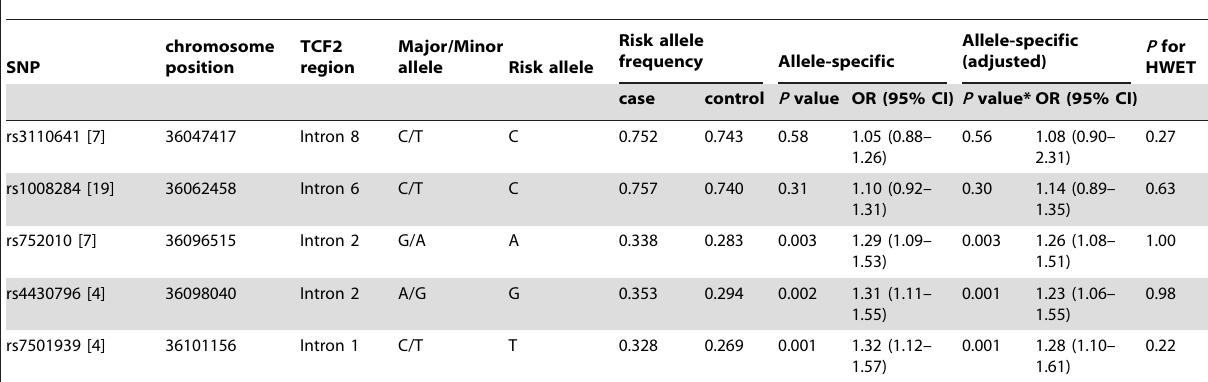
Table 2. Association analysis of TCF2 candidate SNPs for type 2 diabetes.